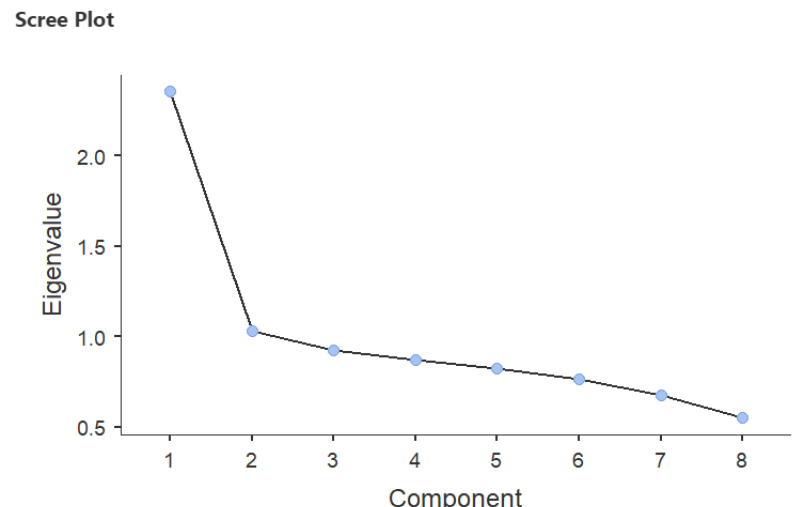
Supplementary Figure S3. Scree plot for reliability judgments following PCA for the “real” misinformation